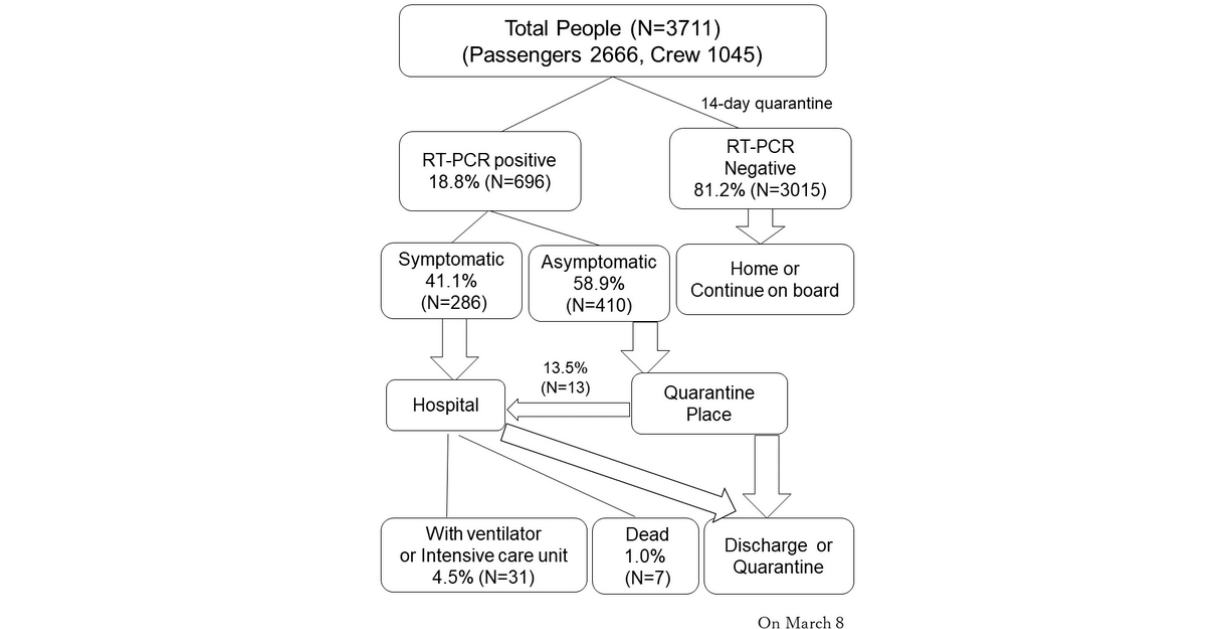
Figure 2. The flowchart of a large-scale cruise ship